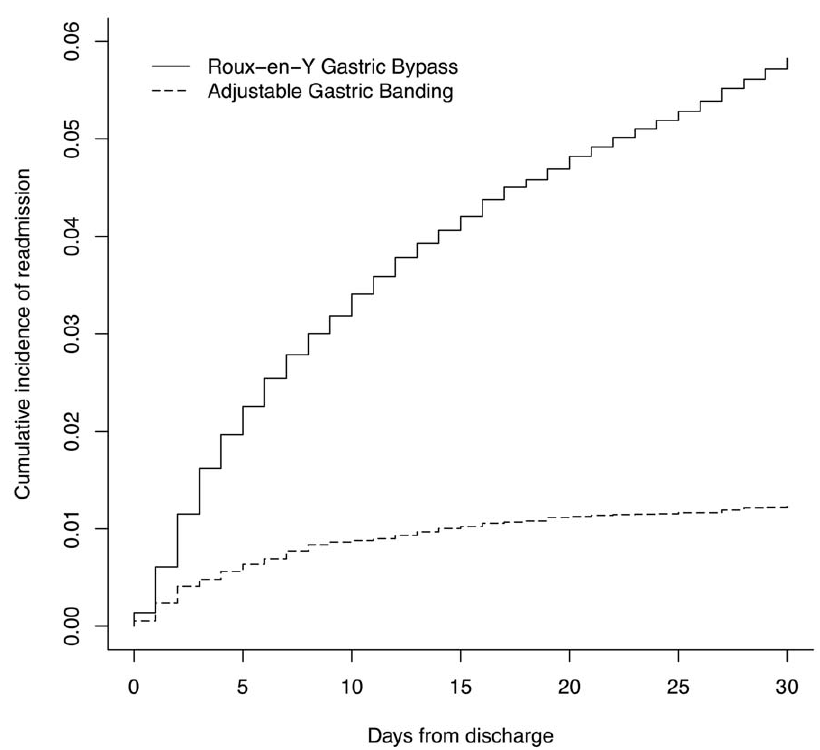
Figure 2. Cumulative incidence of 30-day readmission by surgery.